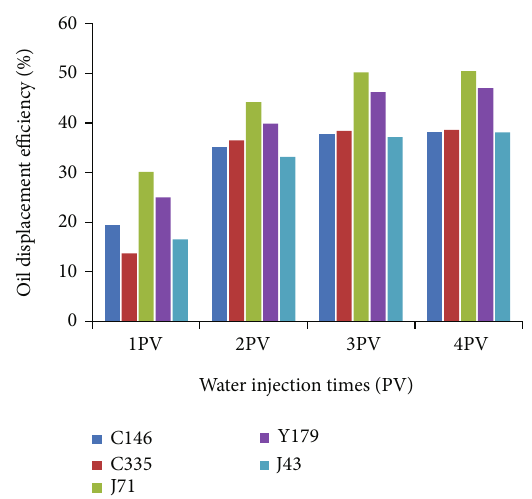
Figure 10: The relationship between water injection times and oil displacement e ffi